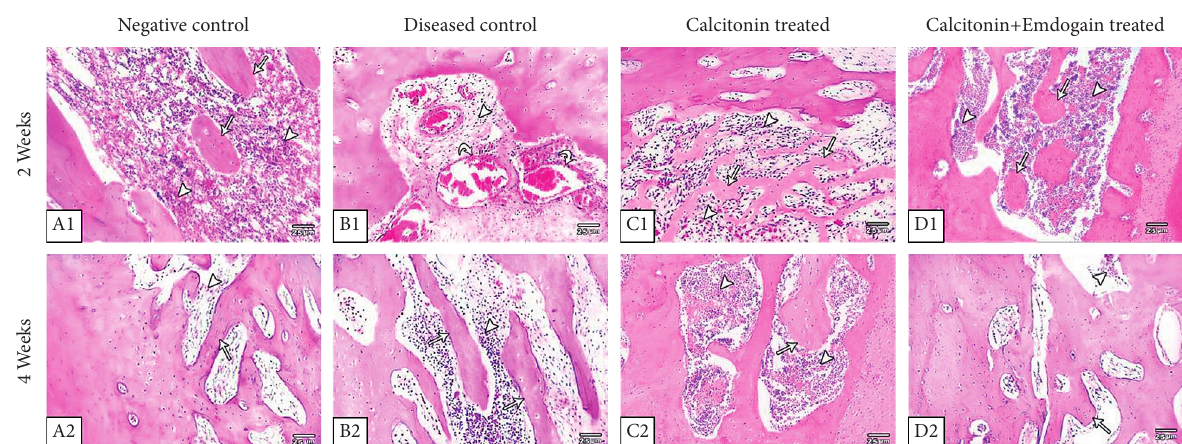
Figure 1: Photomicrograph showing (A1) the bone cavity filled with granulation tissue (arrow head) and the newly formed bone trabeculae (arrow) dispersed in rich highly cellular granulation tissue; (B1) the granulation tissue (arrow head) with severe accumulation of in- flammatory cells and dilated blood vessels (curved arrows); (C1) the newly formed bone trabeculae (arrows) parallel to old bone and separated with highly cellular granulation tissue (arrow head); (D1) the newly formed bone trabeculae are anastomosing (arrows) and wide with highly cellular granulation tissue (arrow head); (A2) a net of growing new bony trabeculae (arrow) surrounded by moderately large bone marrow cavities (arrow head); (B2) the beginning of osteoid tissue formation (arrows) still surrounded by highly vascular granulation tissue (arrow head); (C2) the bone cavities were filled with regular bone trabeculae (arrow) formed of large size osteocytes enclosing bone marrow (arrow head); (D2) thick well-organized bone trabeculae (arrow) with osteoblasts lined the large bone marrow spaces (arrow head) (H&E staining × 100).